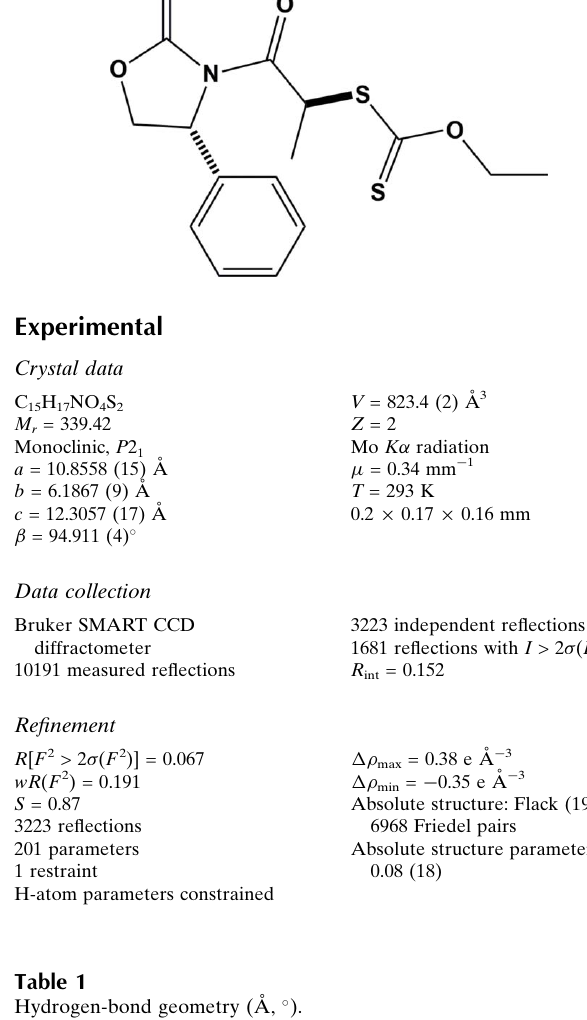
Hydrogen-bond geometry (A˚ , (cid:2)